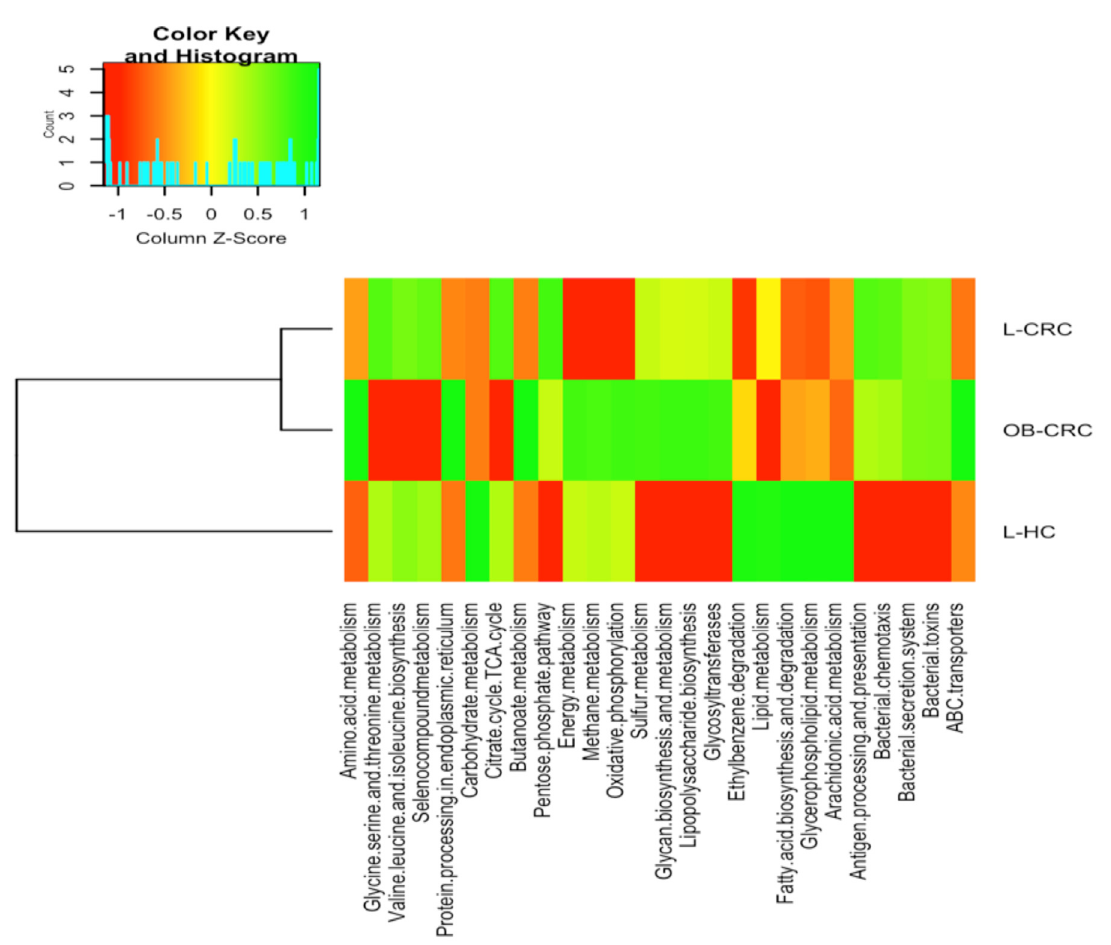
Figure 6. Predicted functional composition of metagenomes based on 16S rRNA gene sequencing data of OB-CRC, L-CRC, and L-HC controls. Heatmap of differentially abundant KEGG pathways identified in the three study groups. The values of color in the heatmap represent the normalized relative abundance of KEGG